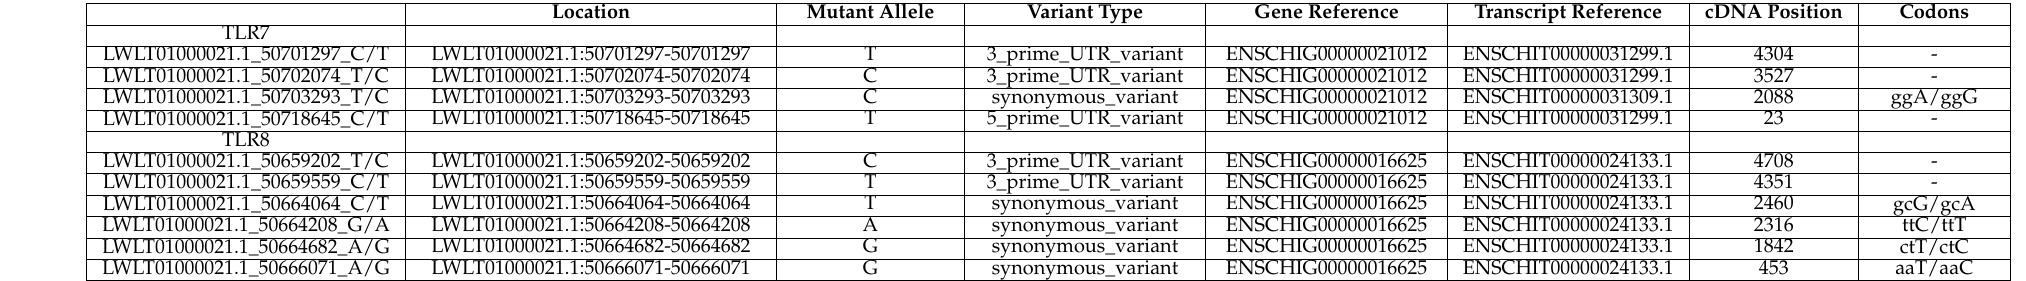
Table 2. New polymorphisms within goat TLR7 and TLR8 genes identified using RNA-seq data.